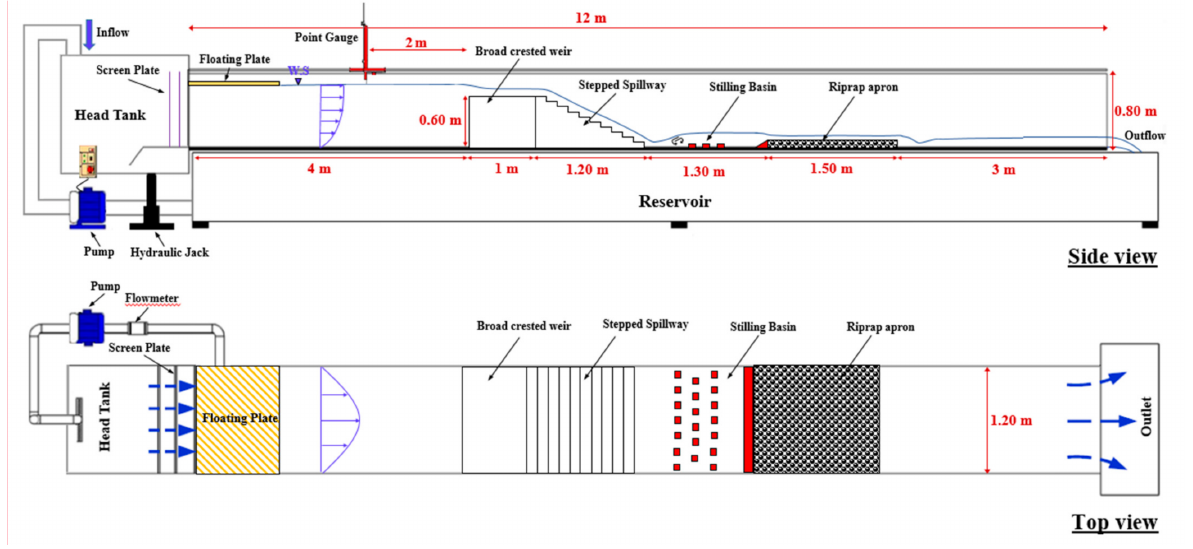
Figure 4. Schematic view of the experimental set-up.